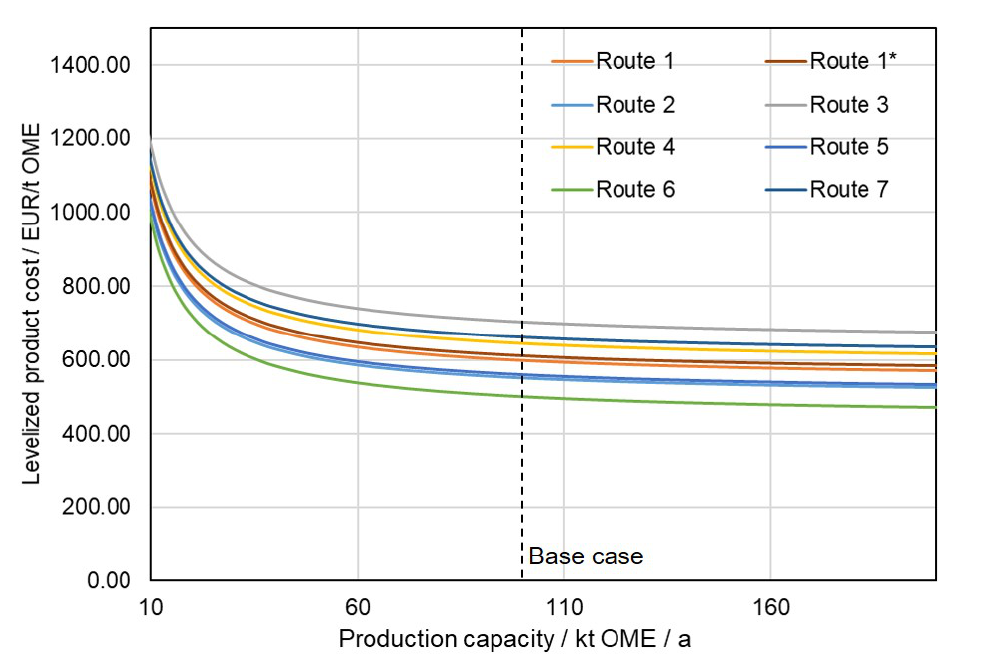
Figure 7. Levelized product cost per t OME for all routes as a function of the plant size for a ME cost of 401